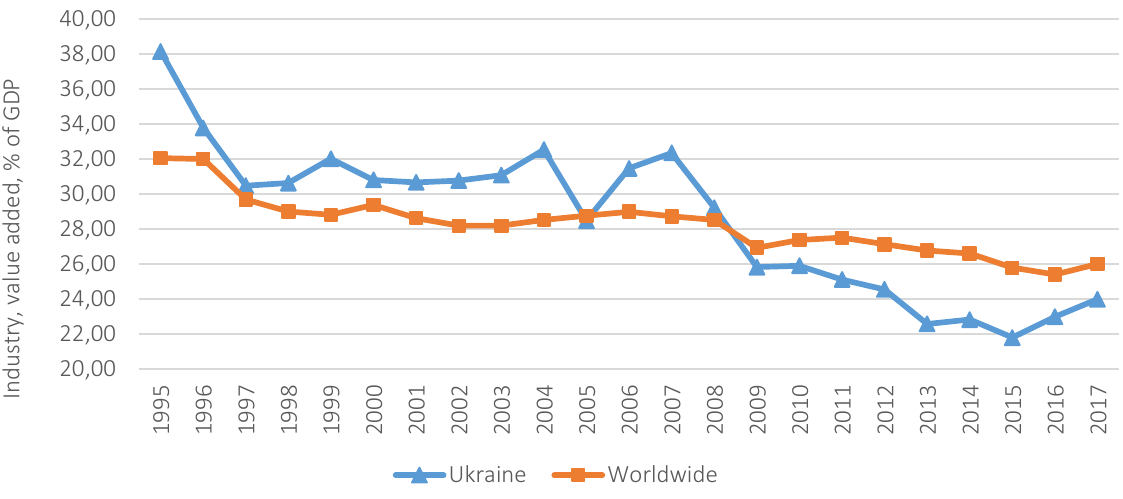
Figure 2. Comparative advantages in value added share in GDP of Ukraine and worldwide,